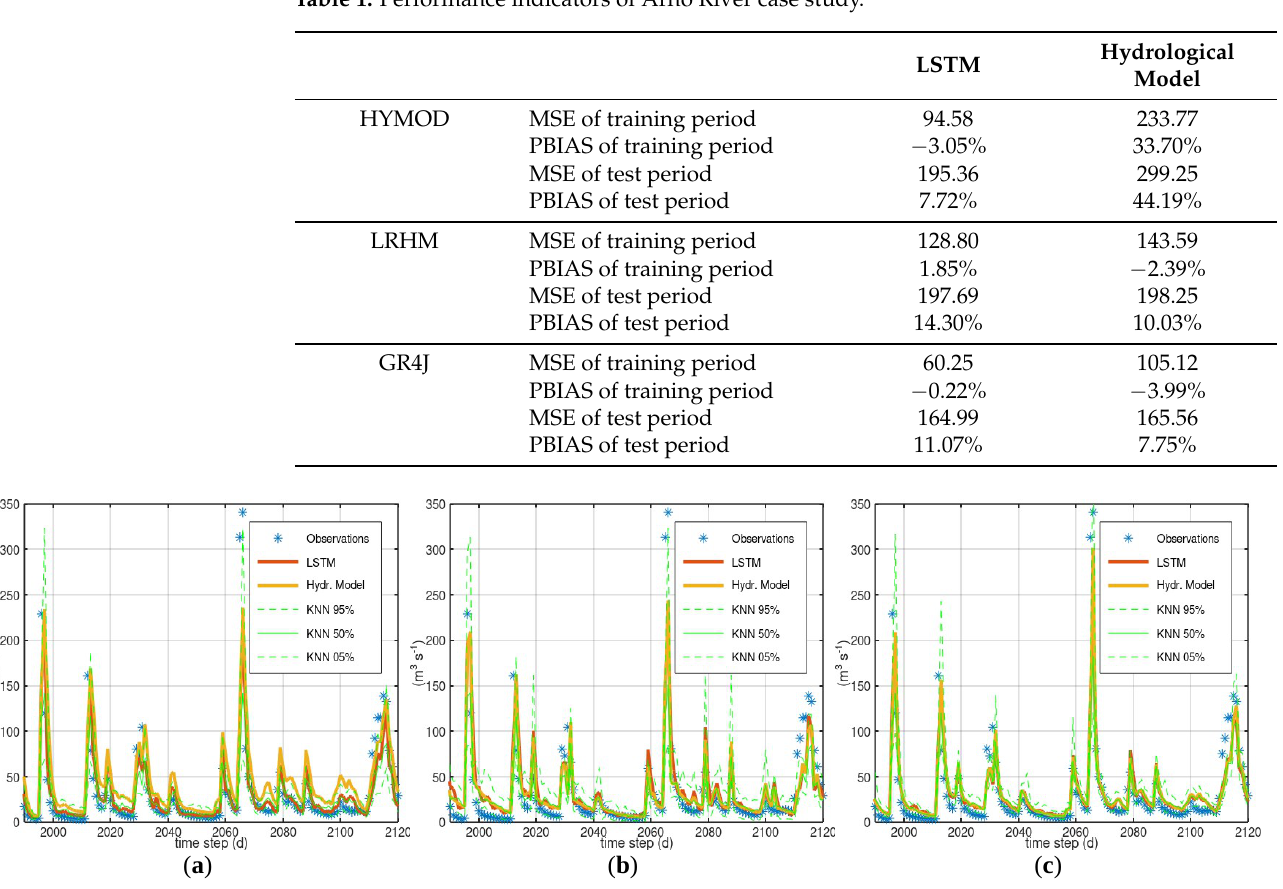
Figure 6. Simulation of Arno River, for time steps 1990–2120 of the test period: ( a ) HYMOD (note how LSTM avoids the overestimation of the low flows); ( b ) LRHM; and ( c )